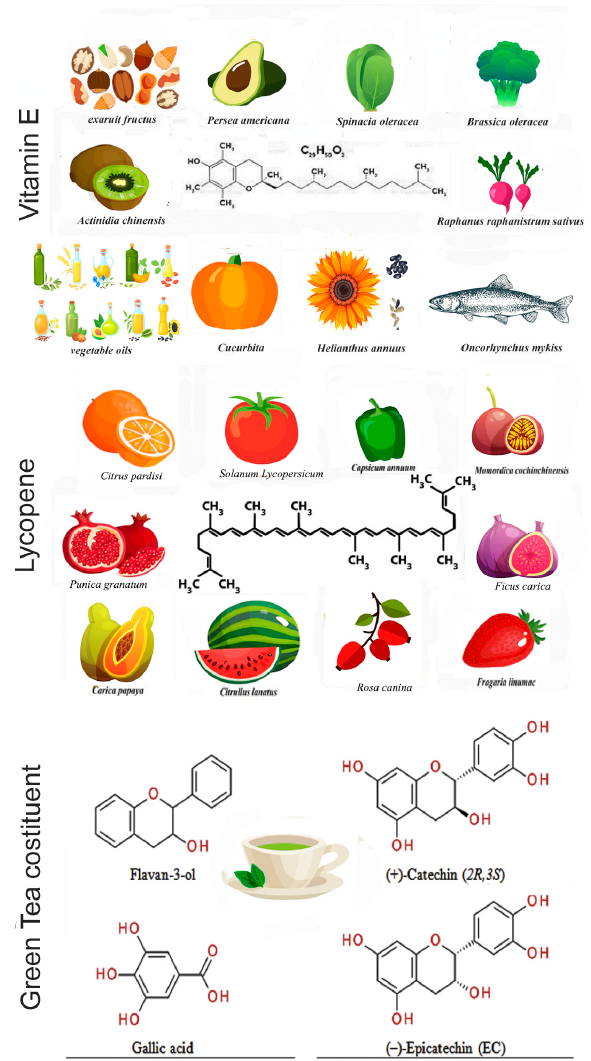
Figure 1. Principal main foods as a source of vitamin E and lycopene, along with green tea constituents (images of sources of antioxidants were taken from https://it.freepik.com) accessed on 1 December 2022.